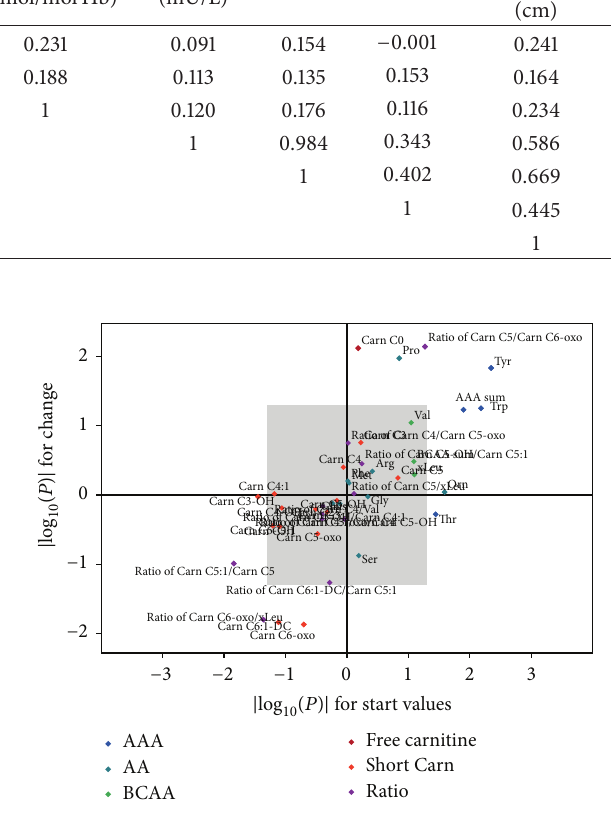
Figure 1: Associations of amino acids (AA) and acylcarnitines (Carn) with HOMA. Associations were calculated at baseline ( 𝑥 - axis) and for changes of AA and Carn to changes of HOMA during the intervention ( 𝑦 -axis) period in all children ( 𝑛 = 80 ). Displayed are the absolute log (𝑝) values of the applied obesity-independent robust regression models for both associations. AAA, aromatic amino acids; BCAA, branched-chain amino